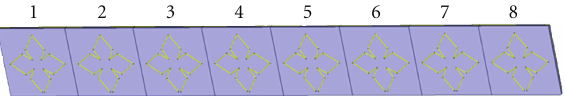
Figure 2: Eight-element linear antenna array.